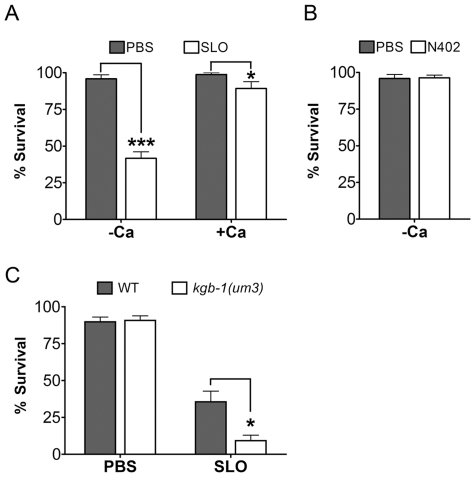
Intoxication of C. elegans by SLO and the requirement of kgb-1 in protecting C. elegans against SLO.(A) Viability of wild-type animals is significantly lower than wild-type animals on the mammalian PFT SLO in calcium-free S-medium. In calcium-complete medium, SLO shows a dampened toxicity to wild-type animals. (B) The mammalian PFT SLO mutant, N402, does not intoxicate wile-type C. elegans in calcium-free S-medium. (C) JNK-like MAPK protects against mammalian PFTs. Viability of kgb-1 (um3) loss-of-function animals is significantly lower than wild-type animals on the mammalian PFT SLO in calcium-free S-medium. Results are the average of three different experiments; error bars indicate standard error of the mean.